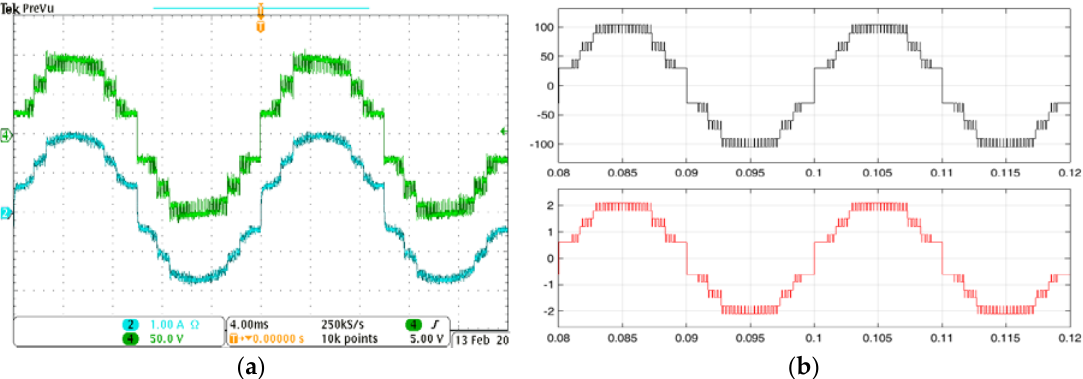
Figure 15. The output voltage (top trace) and current (bottom trace) waveforms with resistive load (50 Ω ) without the auxiliary module. ( a ) experimental ( b ) simulation result. Experimental scale (50 V/div, 1 A/div, 4.0 ms/div).